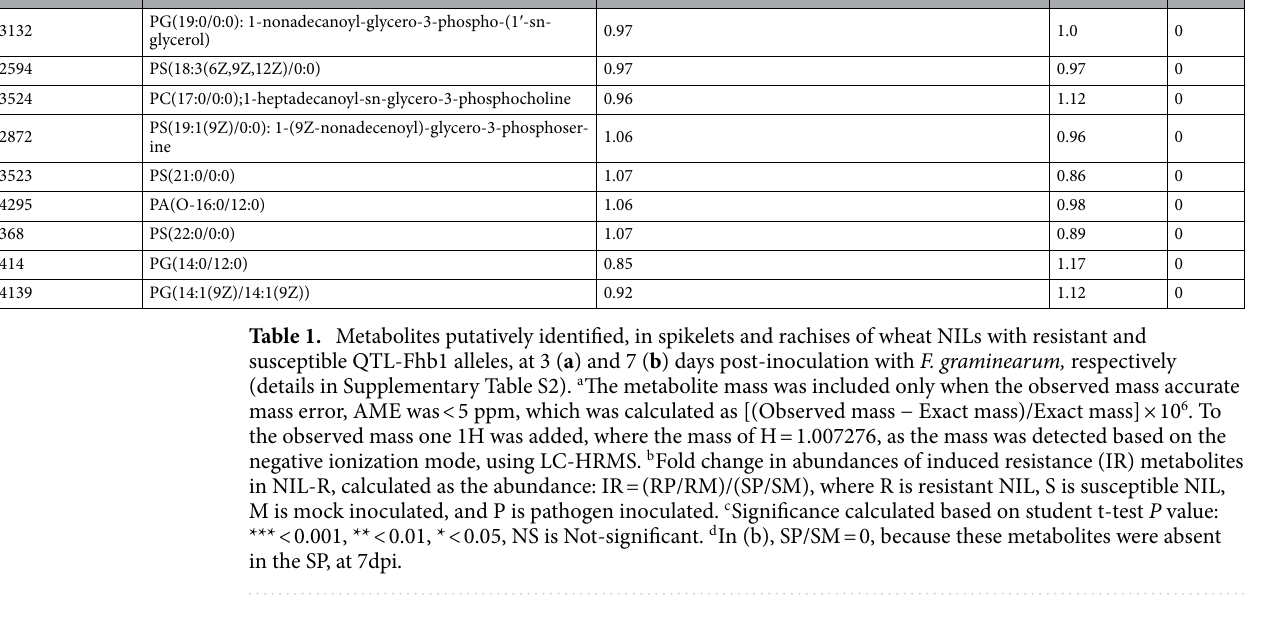
localization signal (Figs. 1b, 2a), moves to the nucleus and increases Ca 2+ concentration. In the nucleus, the Ca 2+ triggered endonuclease, possibly the StCaN2 of the Clade-I, induce AL-PCD (Fig. S1e) 3,13 . In addition, the The DNA laddering and TUNEL assays depicting apoptotic-like DNA fragmentation, and the disappearance of plasma membrane constituents, such as glycerophospholipids, as observed here in wheat (Table 1b), are the cium ion channels, CaM, HRC, ATPases, endonucleases and metacaspases can induce AL-PCD when the HRC is functional, and as well, the roles of hierarchies of R genes involved in the induction of multiple disease resistance